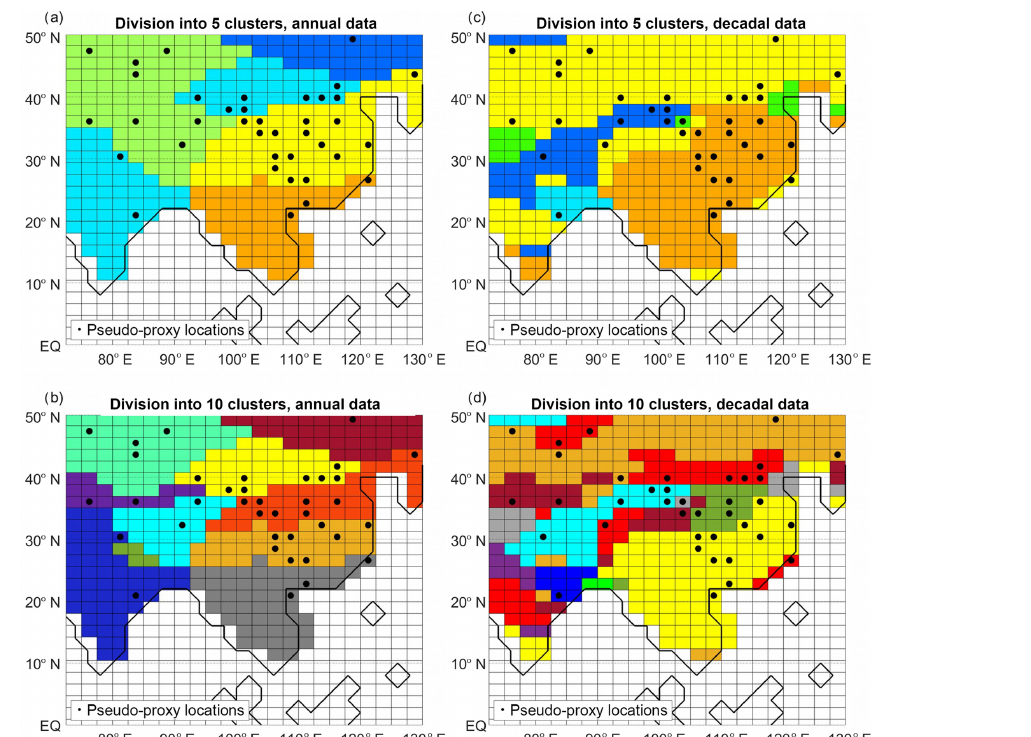
Figure A2. Divisions into clusters (in each plot different colors indicate different clusters), using the simulated JJA precipitation in the instrumental period (years 1996–2005) as input. (a) Annual data, division into 5 clusters, (b) annual data, division into 10 clusters, (c) decadal data, division into 5 clusters, and (d) decadal data, division into 10 clusters. Magenta dots: pseudo-proxy